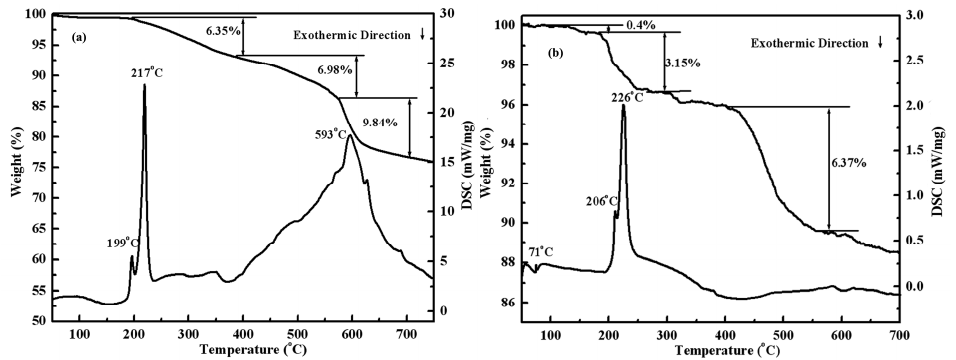
Figure 2. Thermal gravimetry–differential scanning calorimetry (TG–DSC) curves: ( a ) pure KHSO 4 and ( b ) CFA blended with KHSO 4.